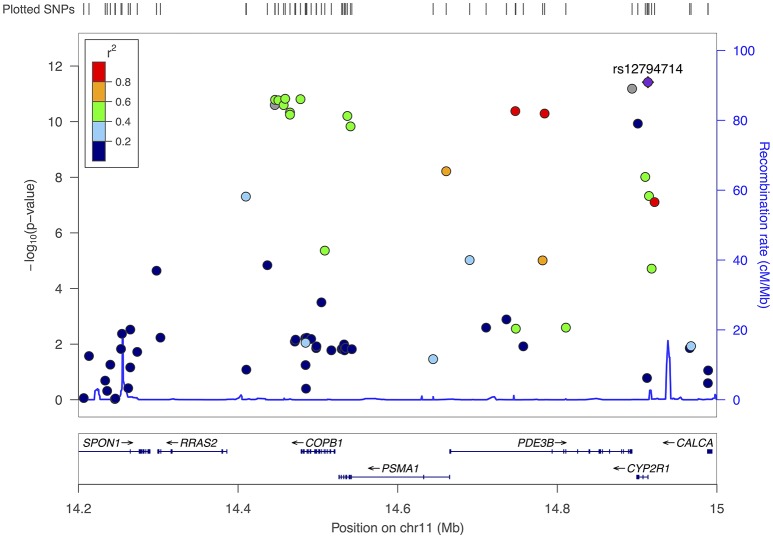
Fine-mapping plot for the region surrounding rs12794714 (chromosome 11), all participants.